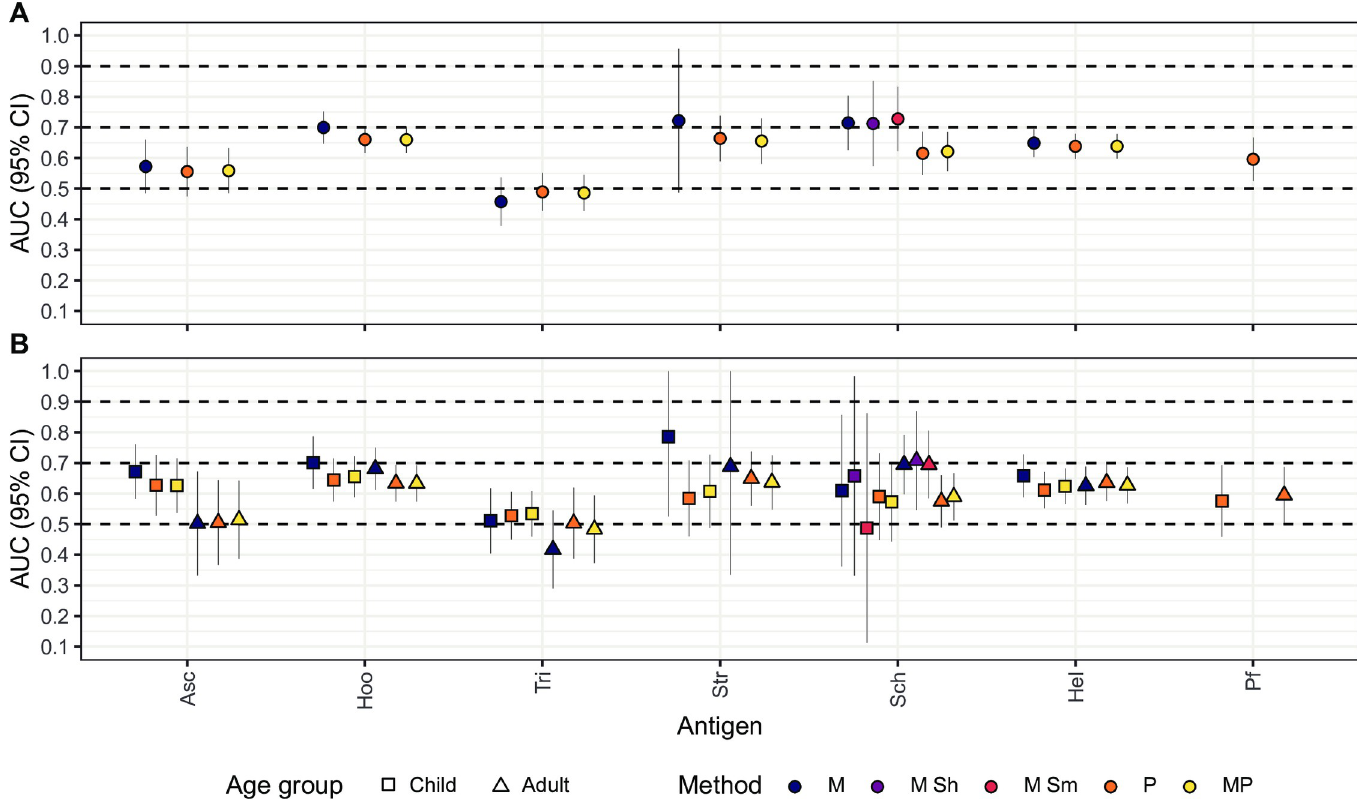
Fig 4. Areas under the curve from receiver operating characteristic curve analysis for total IgE. The performance of total IgE levels to detect helminth or Plasmodium falciparum infections in the whole population is shown in A and stratified by age in B . Dashed lines represent the accuracy thresholds: null if AUC < 0.5, low if 0.5 � AUC > 0.7, moderate if 0.7 � AUC > 0.9 and high if AUC � 0.9. AUC: Area Under the Curve; CI: Confidence Interval; M: Microscopy; P: qPCR; MP: Microscopy and qPCR combined. Asc: Ascaris spp.; Hoo: Hookworm; Tri: Trichuris spp.; Str: Strongyloides stercoralis ; Sch: Schistosoma spp. Hel: Helminths; Pf: Plasmodium falciparum .; Sh: Schistosoma haematobium ; Sm: Schistosoma mansoni . Complementary information for this figure can be found in S2 and S3 Tables .